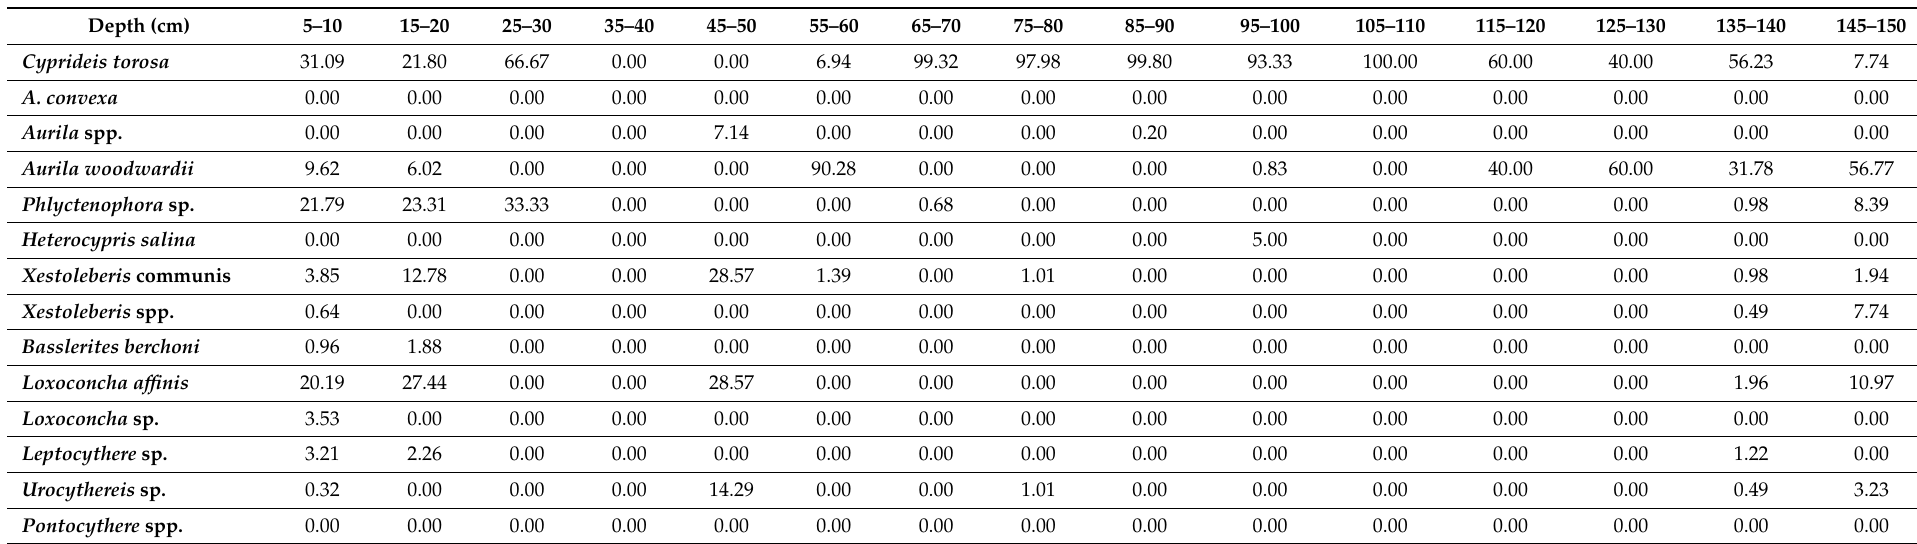
Table A7. Relative frequencies of the ostracod species in the studied samples of AKC3 (5 to 150